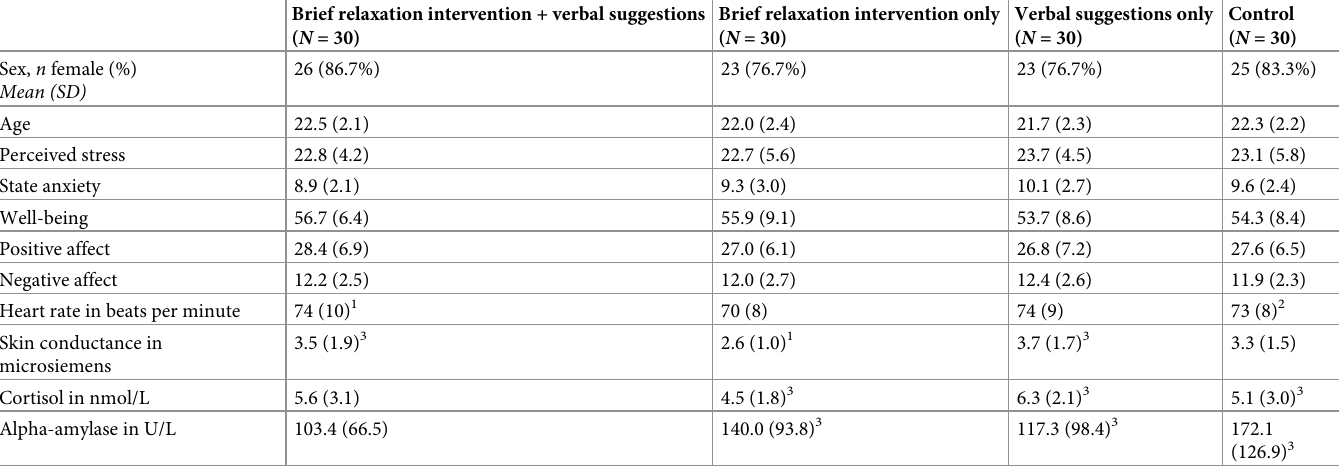
Table 1. Descriptive baseline statistics (mean and standard deviations) for the four conditions